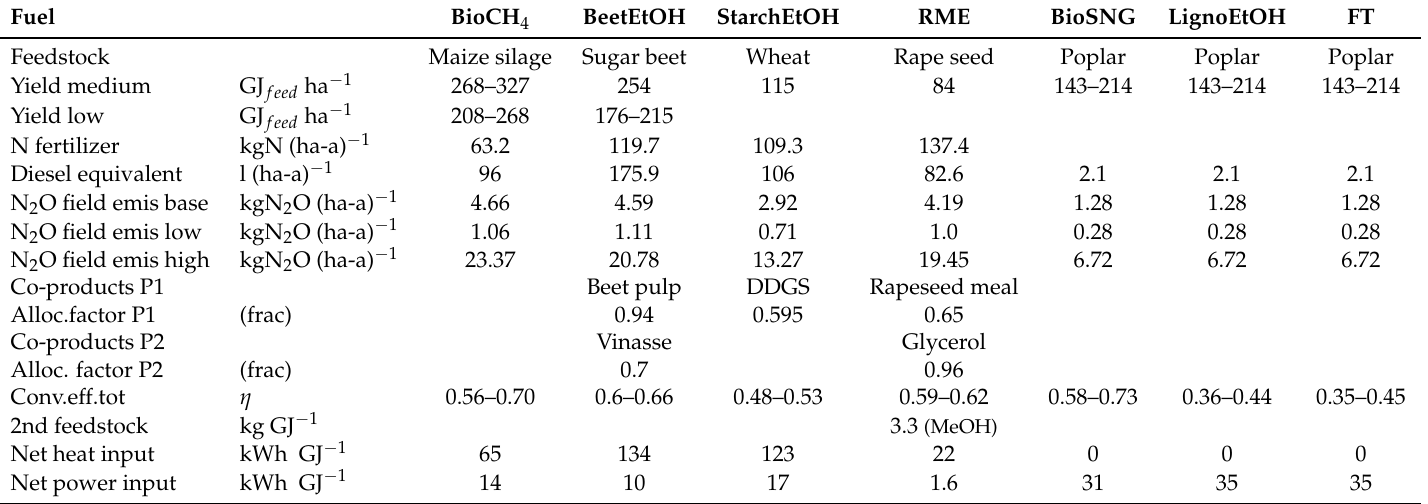
Table 1. Summarized important metrics for the biofuel options included. DDGS, distillers grains with